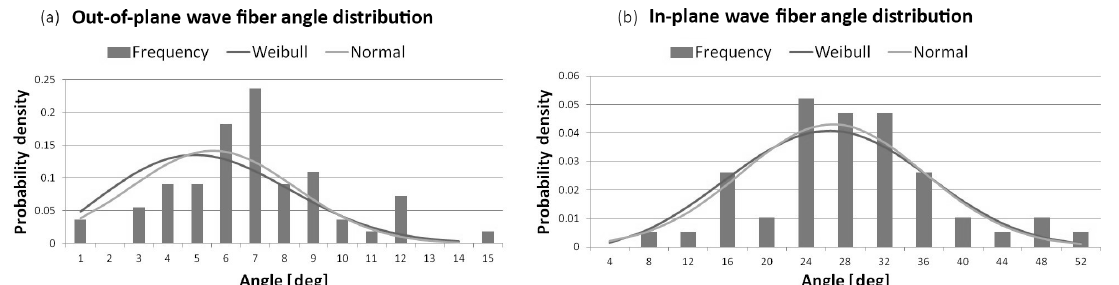
Figure 5. Distribution of all OP (a) and IP (b) wave fiber angles gathered.